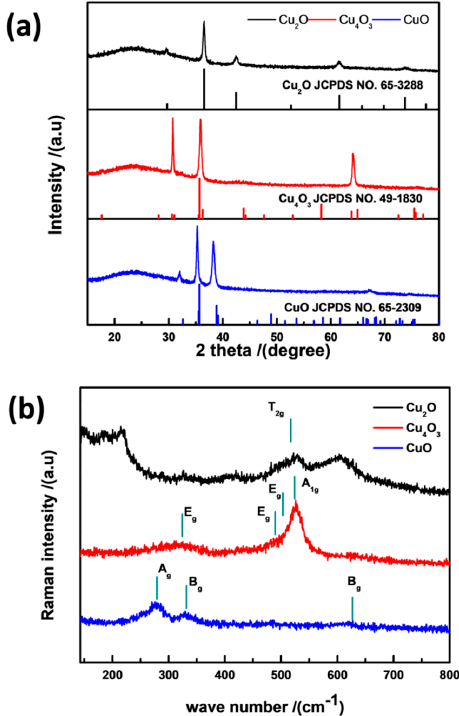
Figure 1. The XRD ( a ) and Raman spectra ( b ) of Cu 2 O, Cu 4 O 3 , and CuO deposited at 0.5 Pa with the flow rates of 8 sccm, 14 sccm, and 24 sccm, respectively.